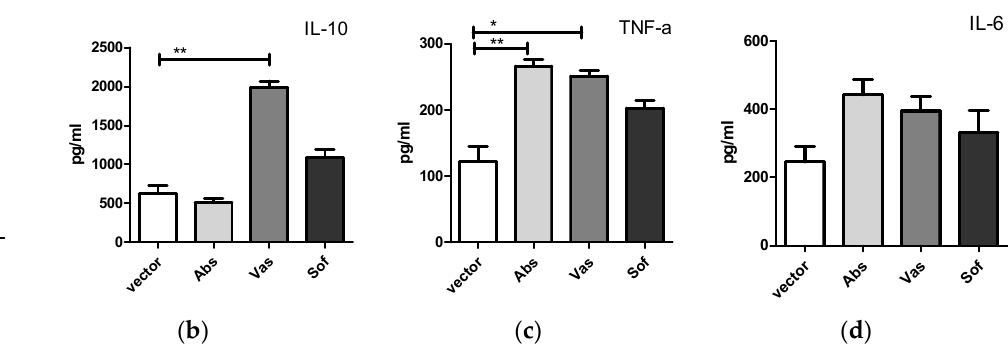
Figure 2. Cytokine secretion by naïve mouse splenocytes after incubation with NS1 proteins of Absettarov (Abs), Vasilchenko (Vas) and Sofjin-Chumakov (Sof) strains of three TBEV subtypes. Splenocytes were incubated with 1 μ g/mL of NS1 for 20 h, and levels of IFN- γ ( a ), IL-10 ( b ), TNF- α ( c ) and IL-6 ( d ) in cell culture fluids were measured by ELISA. Each bar represents the mean value with SD of three mice samples run in duplicates. Statistically significant differences (* p < 0.05, ** p < 0.01) determined by the Student’s t-test of individual strains compared to the vector are labeled.